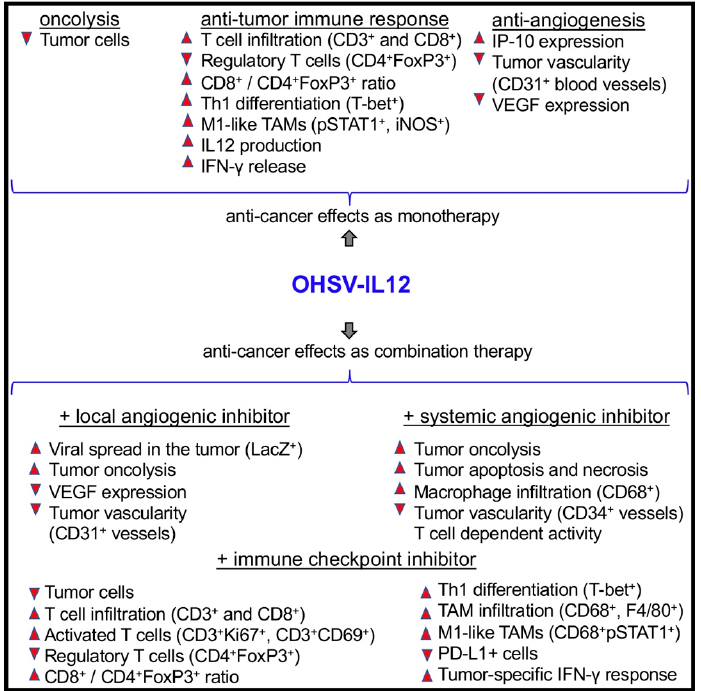
Figure 5. Anti-tumor effects of OHSV-IL12 treatment as mono- and combination-therapies. OHSV-IL12 treatment as monotherapy leads to three distinct anti-cancer effects: 1. Oncolysis, leading to reduction of cancer cells; 2. Induction of anti-tumor immunity, which is characterized by increased intratumoral infiltration of T cells, reduction of regulatory T cells, increased T effector/regulatory T cell ratio, enhanced Th1 differentiation, increased polarization of macrophages toward anti-tumoral M1-phenotype, and increased production of IL-12 and IFN- γ ; and 3. Inhibition of tumor angiogenesis as demonstrated by reduced CD31 + blood vessels and increased expression of vascular endothelial growth factor (VEGF) and interferon inducible protein 10 (IP-10). Because of these three aforementioned unique anti-cancer potentials, OHSV-IL12 was tested in combination with local or systemic antiangiogenic inhibitors and immune checkpoint blockade. The combination of OHSV-IL12 + local angiogenic inhibitor produces anti-tumor e ff ects by increasing intratumoral virus spread (as determined by X-gal staining for viral LacZ expression) and oncolysis, and by reducing CD31 + tumor vascularity and VEGF expression. The anti-tumor e ff ects of the OHSV-IL12 + systemic angiogenic inhibitor are characterized by increased lysis of cancer cells and macrophage (CD68 + ) infiltration into tumors, increased apoptosis and necrosis in the tumor microenvironment, reduced tumor vascularity, and T cell dependent anti-tumor activity. OHSV-IL12 + immune checkpoint inhibitor produces robust and multifaceted anti-cancer activities, which include: oncolysis, increased infiltration of T cells and activated T cells into tumors, reduction of immunosuppressive regulatory T cells, increased e ff ector (CD8 + ) / regulatory T cell (CD4 + FoxP3 + ) ratio, Th1 di ff erentiation, tumor-associated macrophage (TAM) infiltration and macrophage polarization towards M1-type, reduction of immune checkpoint PD-L1 positive cells, and induction of tumor-specific IFN- γ response. Upward and downward triangles indicate ‘increase’ and ‘decrease’,